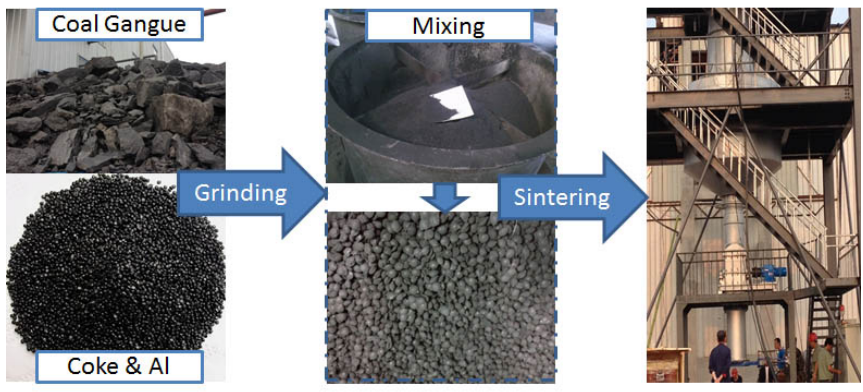
Figure 5. The continuous nitriding furnace for SiAlON